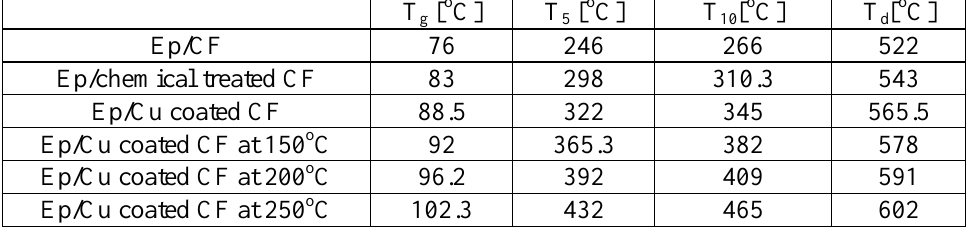
Fig.2: Thermal analysis data of Ep/CF, Ep/chemical treated CF and Ep/Cu coated CF composites at a different treatment temperatures (150, 200, 250) o C.